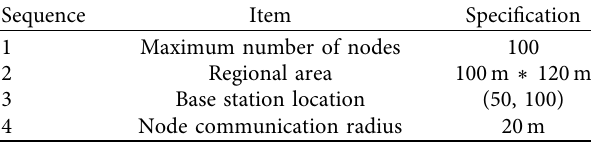
Table 2: Experimental scenario design